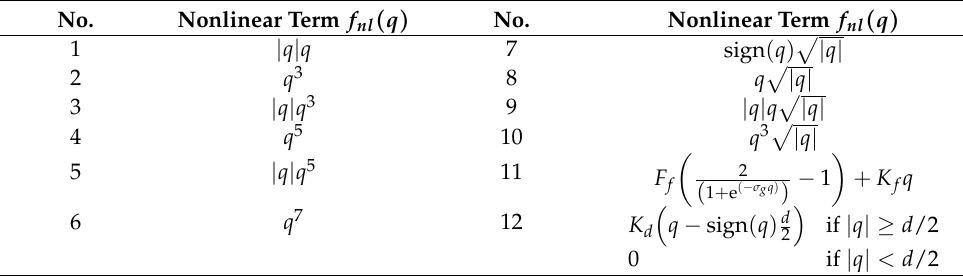
Table 2. Nonlinear terms considered in the library. No. Nonlinear Term f nl ( q ) No. Nonlinear Term f nl ( q